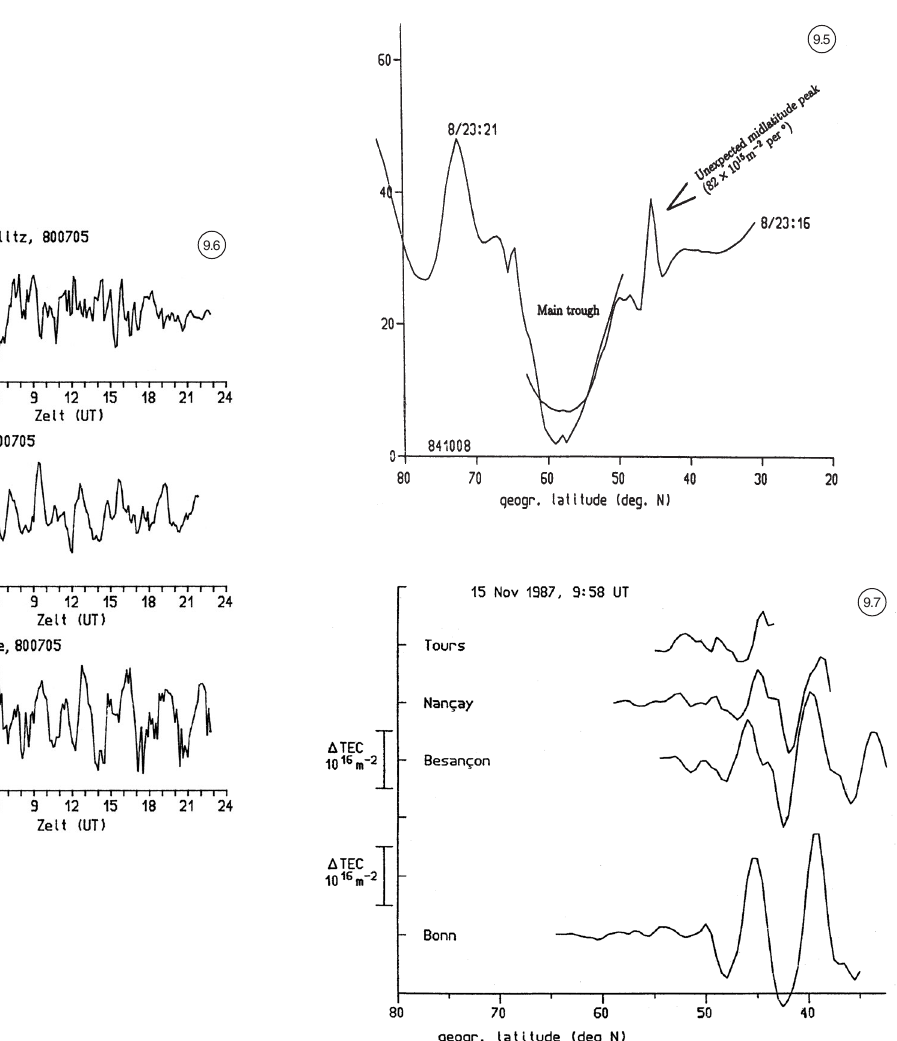
Fig. 9.5. Unexpected mid-latitude peak (sharp mid-latitude gradients) on 8 October 1984, around 23 LT (Leitinger, 1993). Electron content in units of 10 16 m -2 versus geographic latitude from NNSS Diff. Doppler, re- ceiving stations Graz (47.1N, 15.4E, right hand curve) and Uppsala (51.6N, 10.1E left hand curve). The mid- latitude peak is clearly no artefact: it exists in 6 consecutive satellite passes recorded at Graz between about 20 h LT on October 8 and 01 h LT on October 9. Fig. 9.6. Large amplitude TIDs from the Faraday effect on the VHF signals of the geostationary satellite SIRIO. High pass filtered TEC in units of 10 15 m -2 versus time in hours UT. Fig. 9.7. Example for strong latitudinal and longitudinal gradients from TIDs (Putz et al. , 1990). High pass fil- tered electron content in units of 10 16 m -2 versus geogr. latitude from NNSS Diff. Doppler, receiving stations Tours (47.4N, 0.7E), Nançay (47.3N, 2.2E), Besançon (47.3N, 6.0E), Bonn (50.5N,